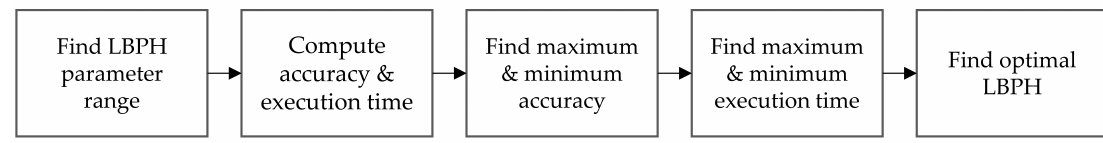
Figure 4. Experiment framework for local binary pattern histogram (LBPH)